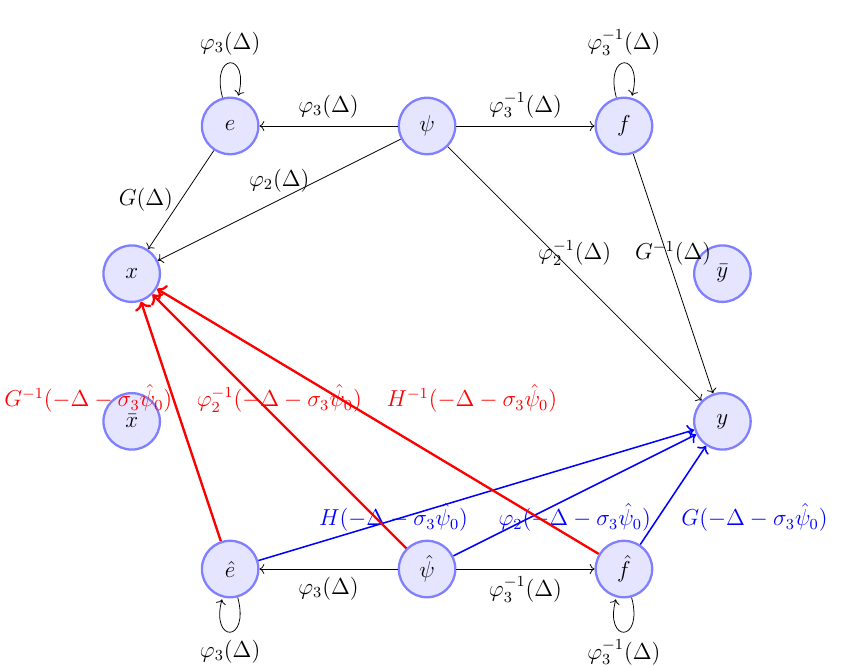
Figure 5 . The additional relations (in red and blue) together with some of the relations from (cid:12)gures 2 and 3 for